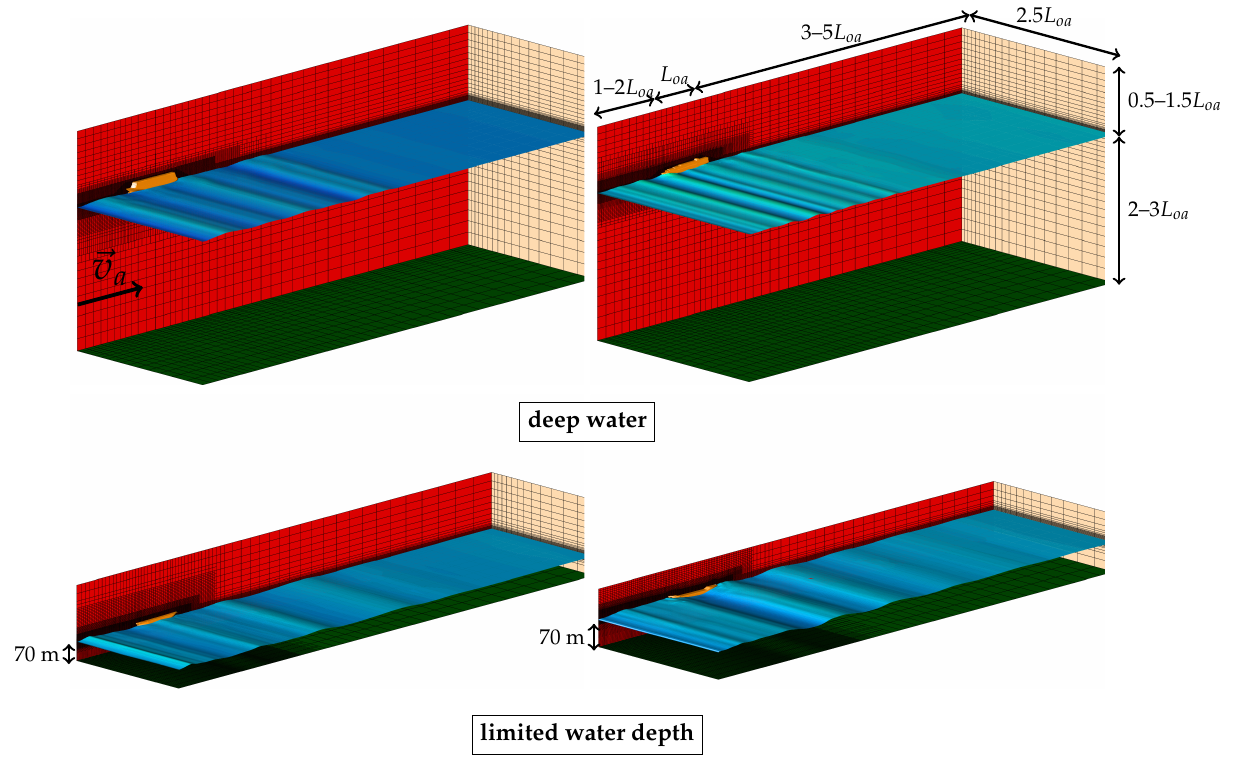
Figure 2. Overview about numerical grids for cruise ship ( top left ), containership ( top right ), liquid natural gas (LNG) carrier ( bottom left ), chemical tanker ( bottom right ).